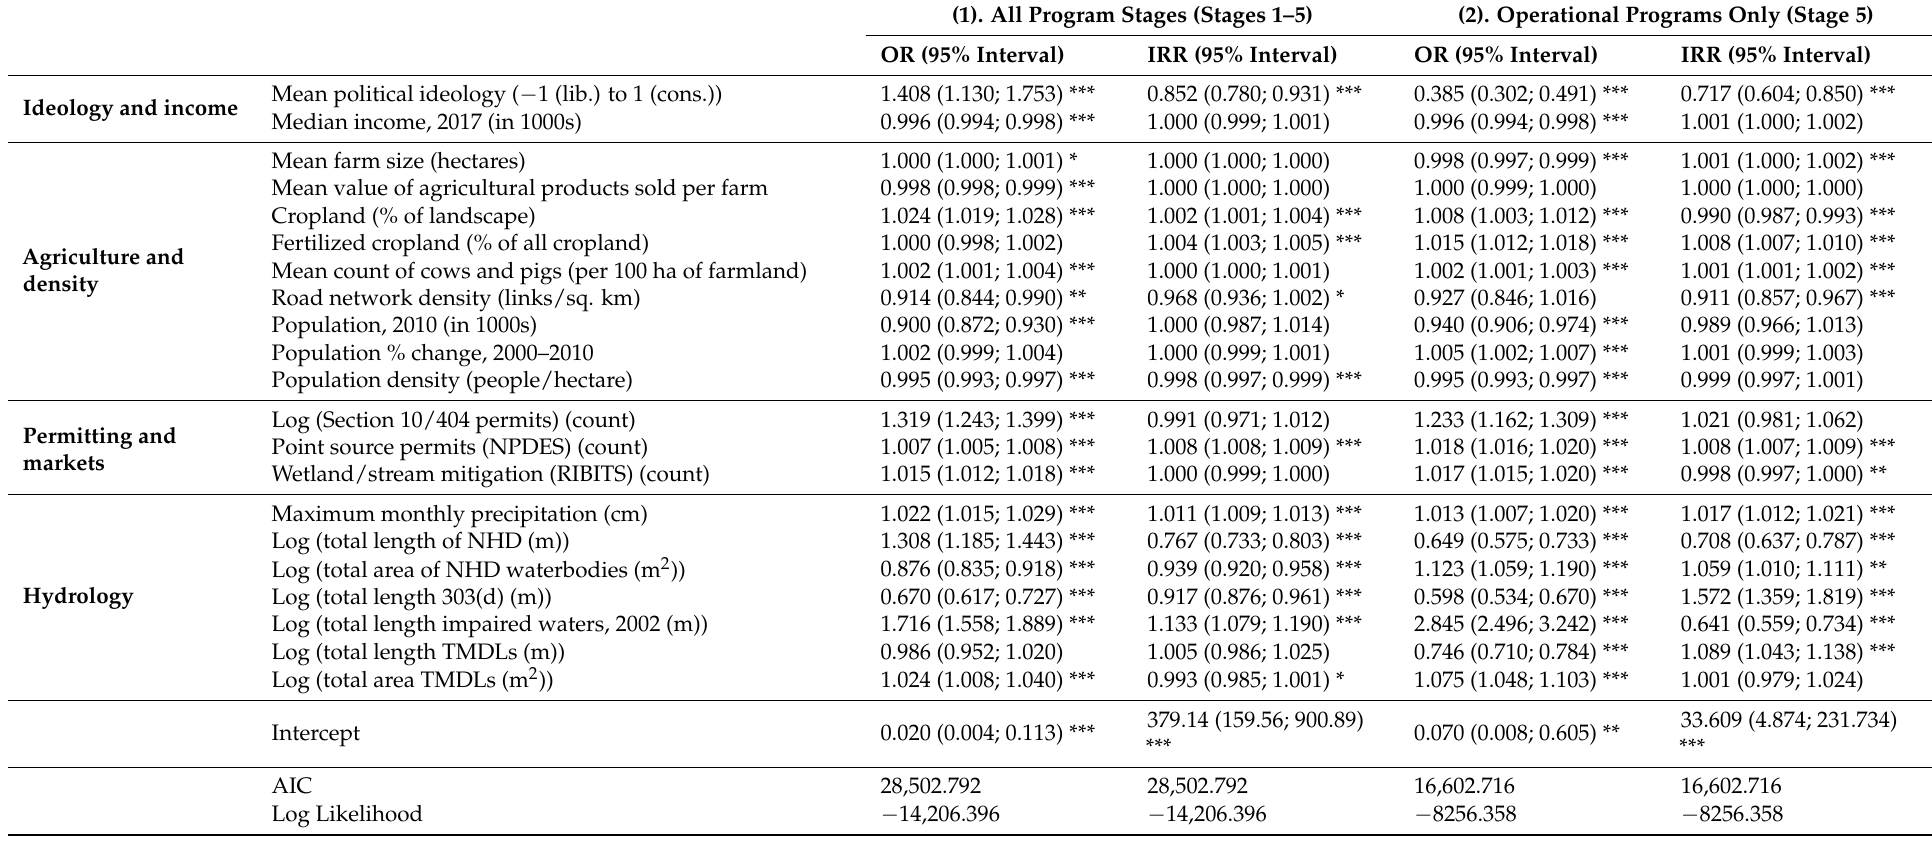
Table A3. Hurdle regression model results showing sensitivity analysis whereby hydrological variables (except precipitation) are summarized to the HUC-6-level (50% overlap per discussion in Appendix B). Hurdle model predictions of existence and abundance of (1) operational and nonoperational water quality trading programs (all Stages 1–5), and (2) operational water quality trading programs (Stage 5 only). Depicts effects on odds ratios (OR) for binary logistic regressions and on incident rate ratios (IRR) for truncated negative binomial regressions, with 95% confidence intervals for each. n = 6940 tracts for all. * p < 0.1; ** p < 0.05; *** p <